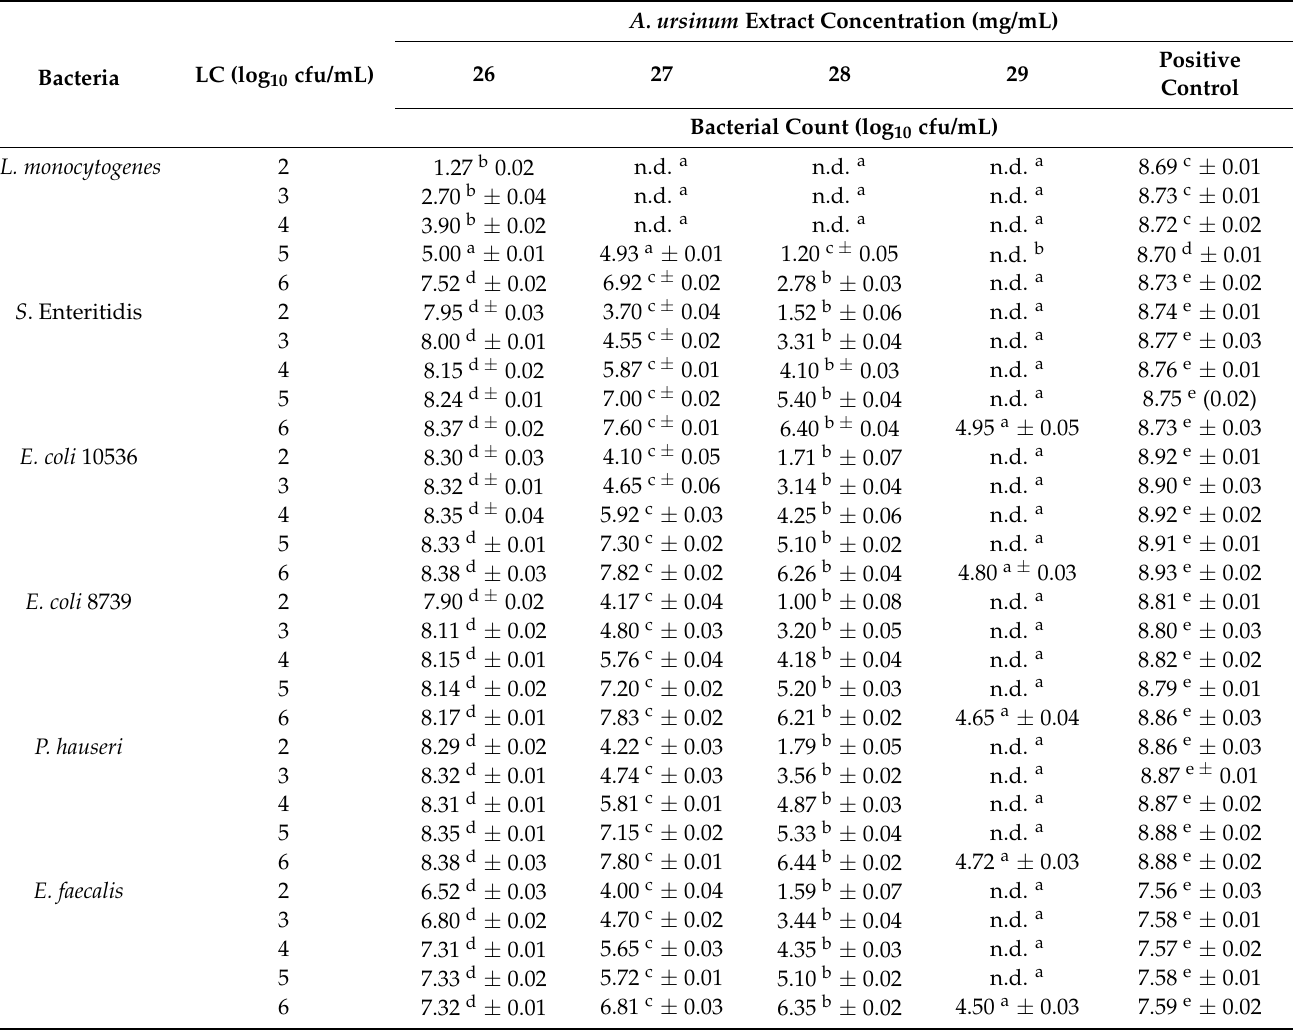
Table 3. Antimicrobial activity of A. ursinum extract at concentrations of 26, 27, 28 and 29 mg/mL.